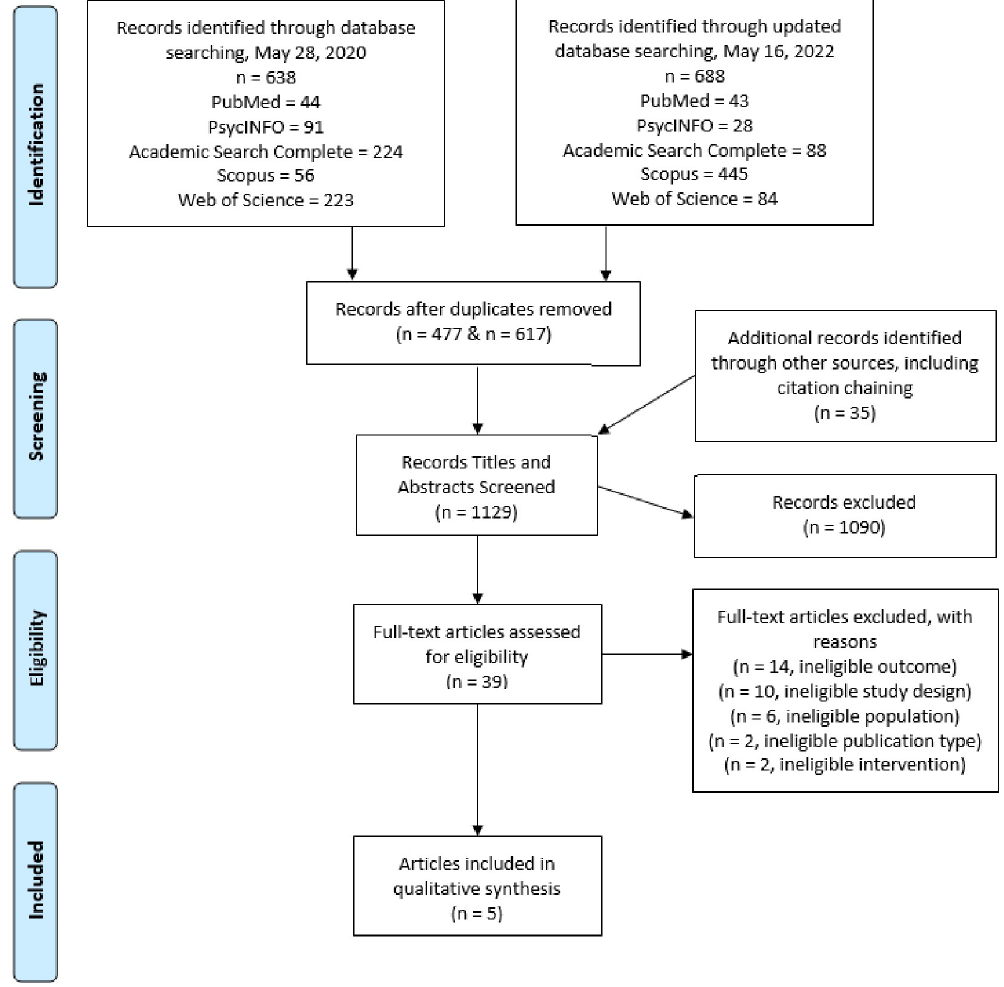
Fig 1. PRISMA flow